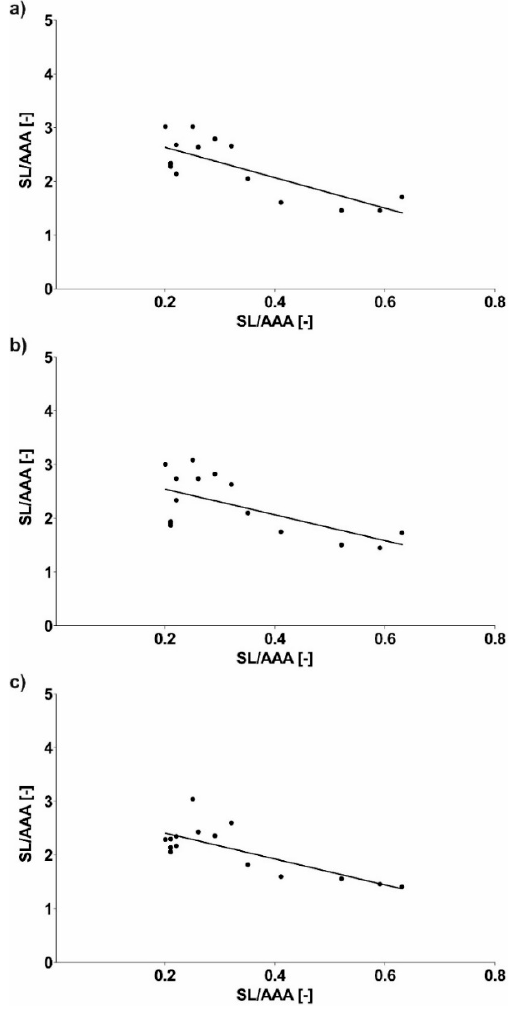
Figure 12. Scatterplot graphic representation of Pearson’s correlation factors rho [-] for the analyzed geometry of SL/AAA in function of WSS values for SL/AAA ( a ) for sharp profile (rho = − 0.7747, p < 0.001), ( b ) for flat profile (rho = − 0.6298, p = 0.011), ( c ) for real profile (rho = − 0.7657, p < 0.001).